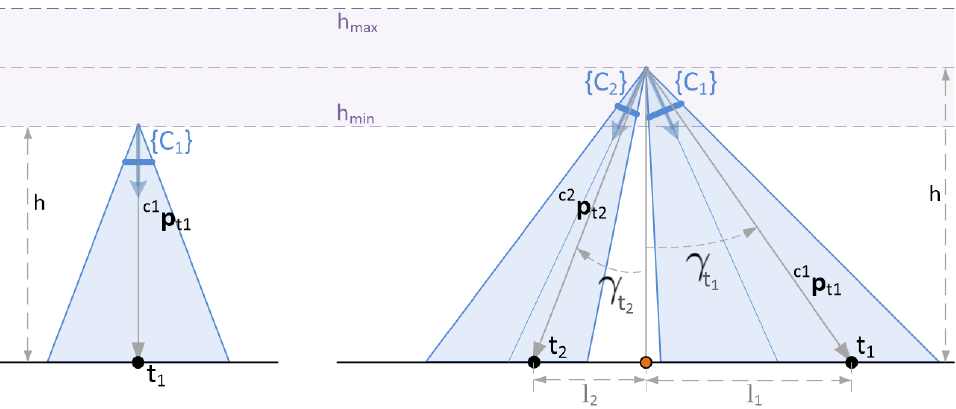
Figure 7. Sketching of two trivial cases. Left: one target. Right: two